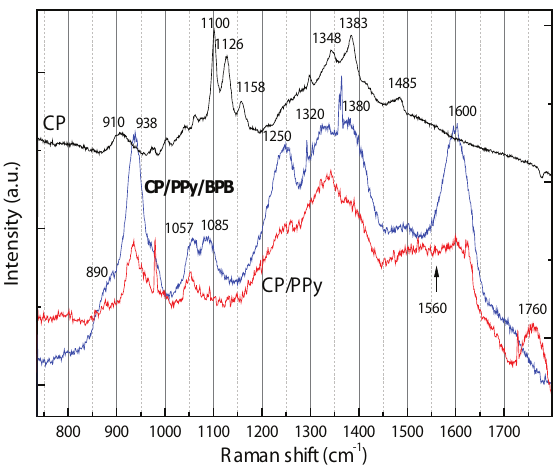
Figure 1: Resonance Raman spectra for CP, CP/PPy and